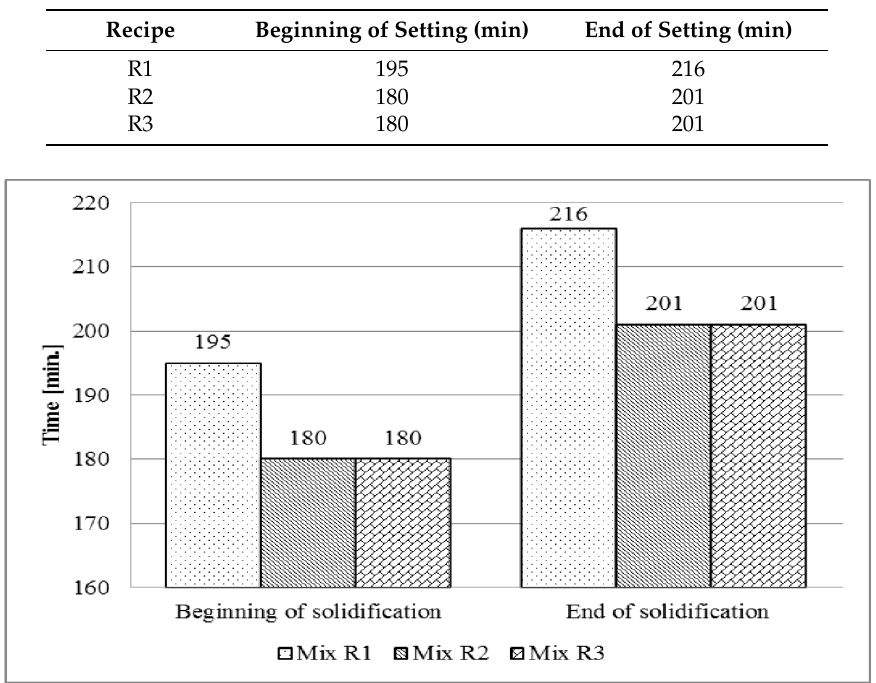
Table 3. The results of the beginning and end of the experimental recipes setting.